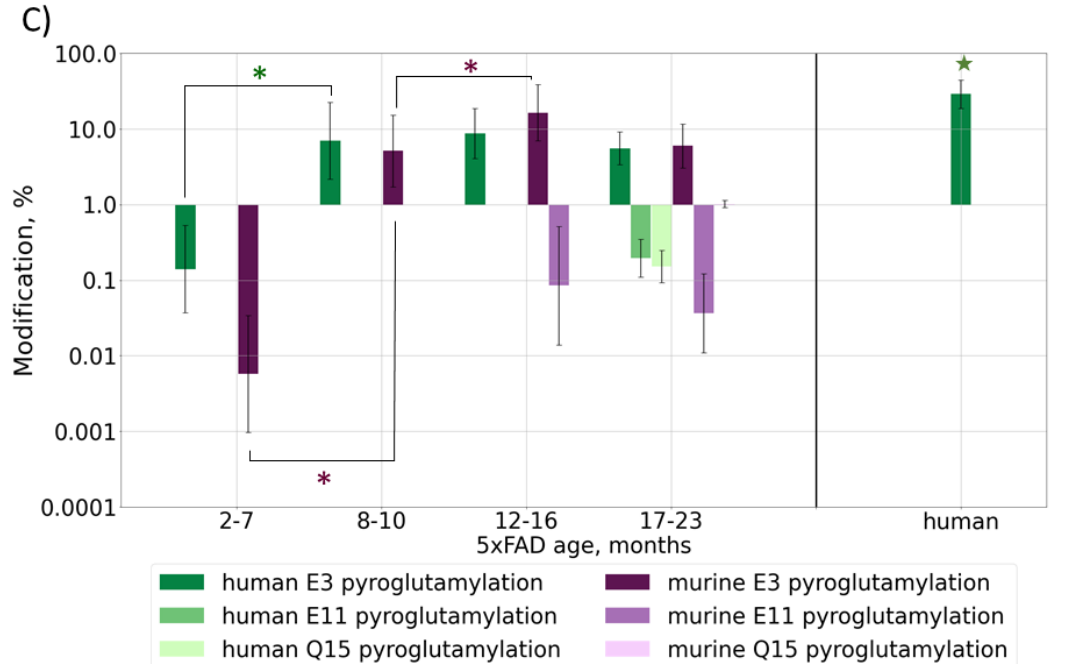
Figure 3. Content of various post-translationally modified (PTMs) A β forms in peptide extracts from 5xFAD mice of different ages or human AD sample: ( A ) deamidation of Q15 and N27; ( B ) phosphorylation of S8/Y10 and oxidation of M35, M(-1); ( C ) pyroglutamylation of E3, E11, Q15. Average values ± SD are shown. For better visualization, mice were grouped by age according to the phases of A β accumulation (Figure 1B). Monthly values can be found in Figure S5. p -values < 0.05 were considered as significant. Significant differences between age groups of mice are marked with asterisks (*). For comparison with the human AD reference brain sample, average values for mice over 6 months of age were taken (shown with stars ). p -values can be found in Supplementary Table S3.